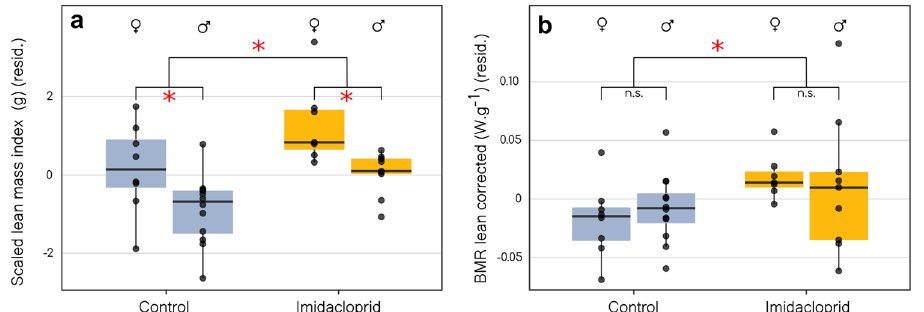
Figure 3. ( a ) Residuals of Scaled Lean Mass Index (day 800) split by sex and early-life treatments (Control in blue and Imidacloprid in orange). Control (n = 20) = Ad libitum -Control + Restricted-Control / Imidacloprid (n = 16) = Ad libitum -Imidacloprid + Restricted-Imidacloprid). ( b ) Lean mass corrected Basal Metabolic Rate (model residuals) (day 800) according to the sex and the two treatments (Control and